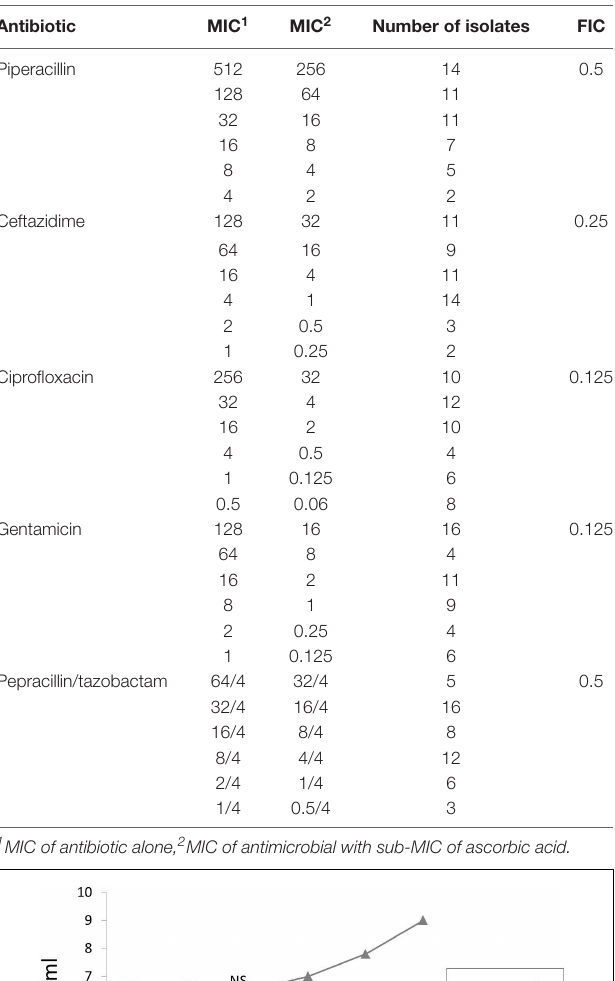
Figure 1 . The MIC50 and MIC90 of ascorbic acid, which inhibit the growth of 50% and 90% of isolates, were 312.5 and 625 µ g/ml, respectively.